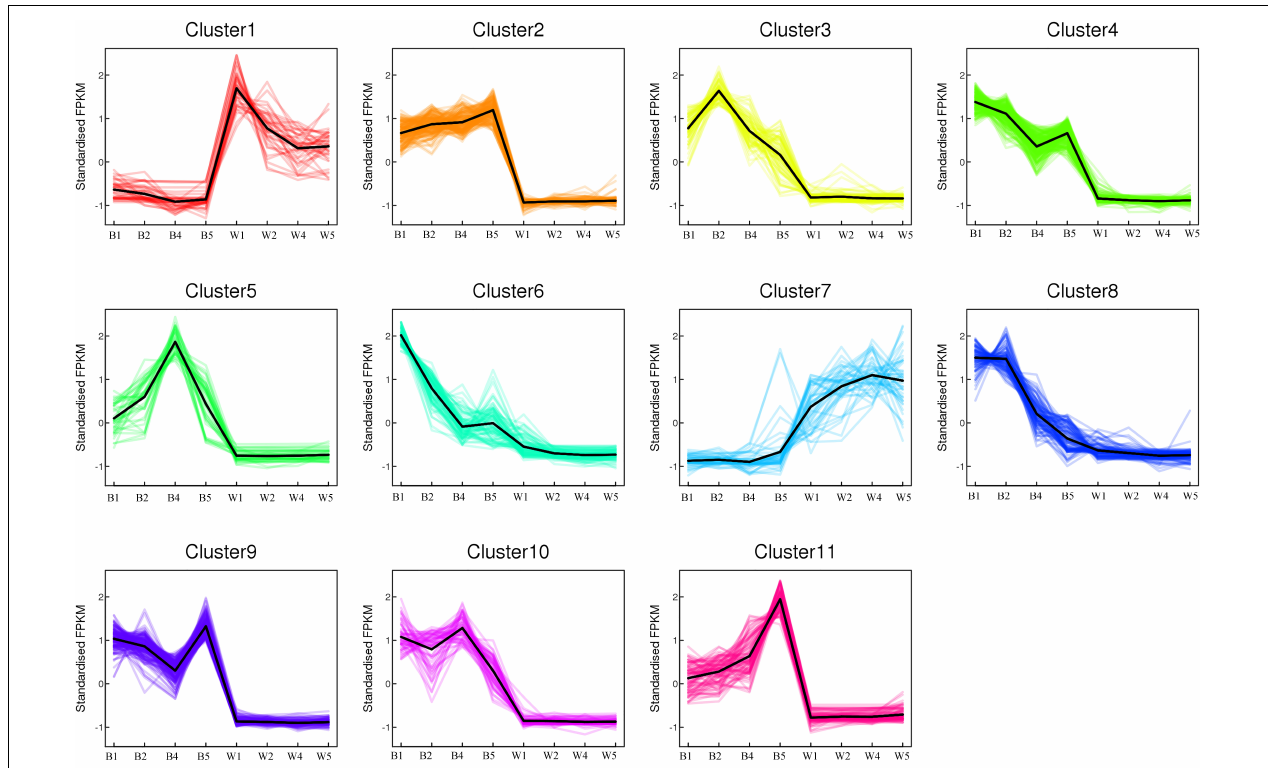
FIGURE 5 | K-means analysis of 1,066 DEGs identified from Venn diagram. A total of 11 clusters were identified based on the expression profiles of these